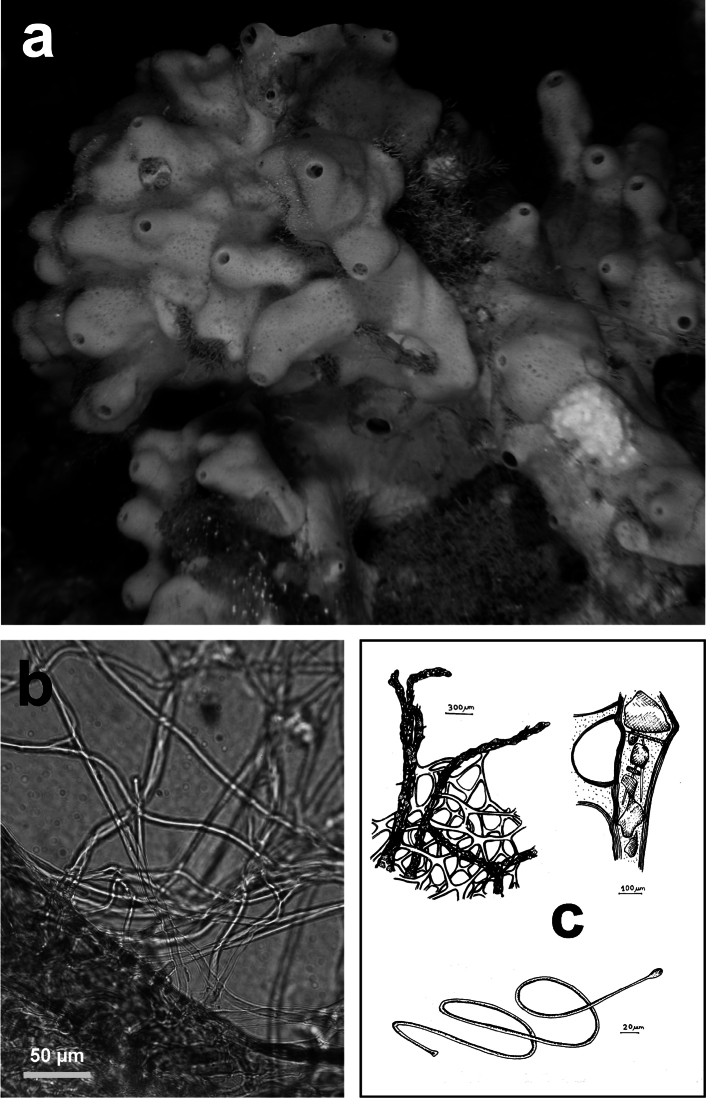
Ircinia oros. a specimen with an epibiotic haliclonid (lightest area) b magnifications (LM) of typical irciniid skeletal filaments c schematic drawings of cored primary fibres, uncored secondary network and a filament with the terminal knob. c modified from Rubió-Lois et al. (1981).